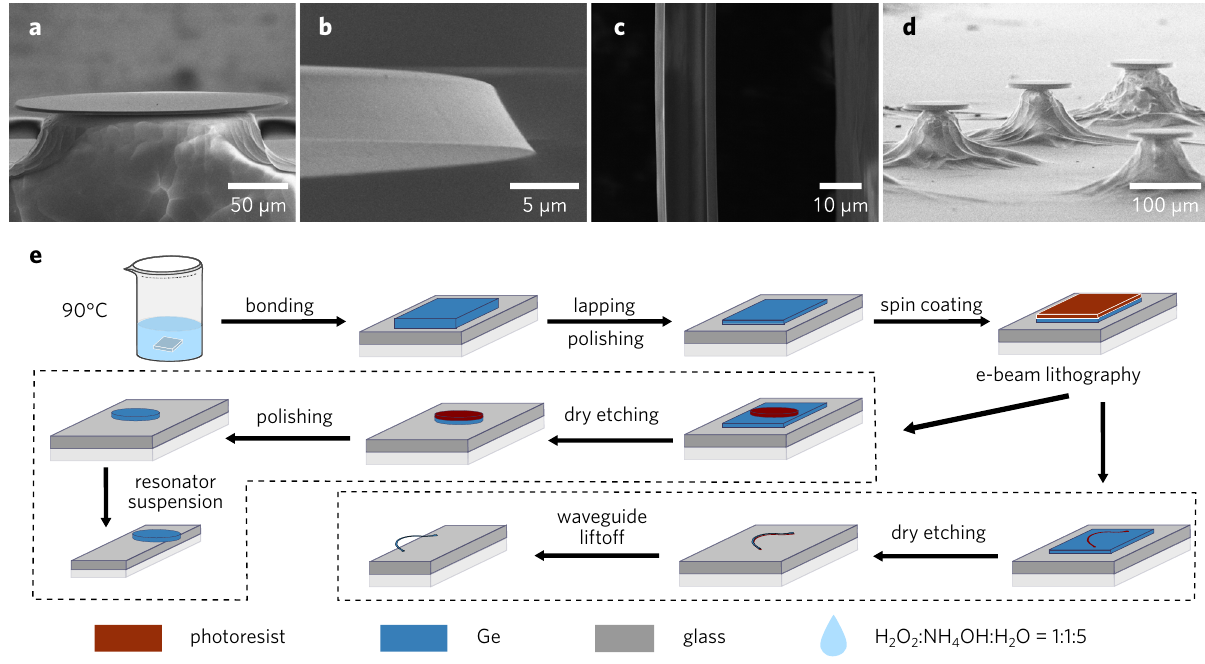
Fig. 1 | Images and fabrication of the non-epitaxial Ge microresonators and suspended waveguides. a SEM image of a non-epitaxial Ge microresonator. The 450 μ m diskissupported byaglass pillar. b Magni fi edview of the